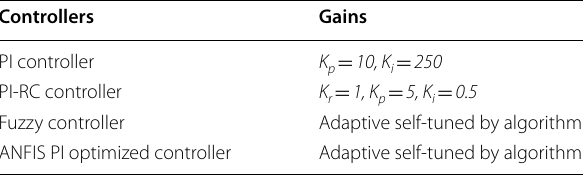
Table 2 Rule based representation